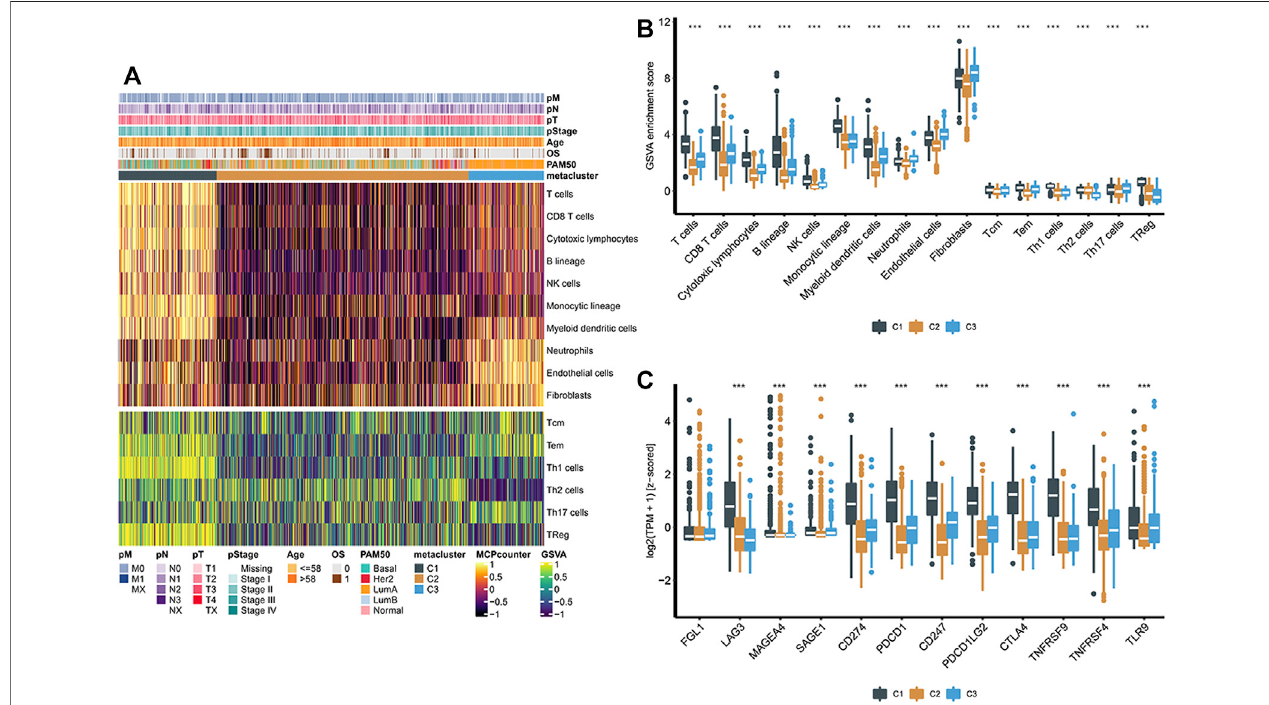
FIGURE3|(A) Heatmaps ofthepopulationabundanceofimmunecellsandstromalcellsinthethreesubtypesofbreastcancer; (B) Enrichmentscoresofdifferent immune cells and stromal cells in three subclasses of breast cancer; (C) Boxplot showing the expression levels of 12 immune checkpoint genes in three breast cancer subclasses. **** indicates that p <